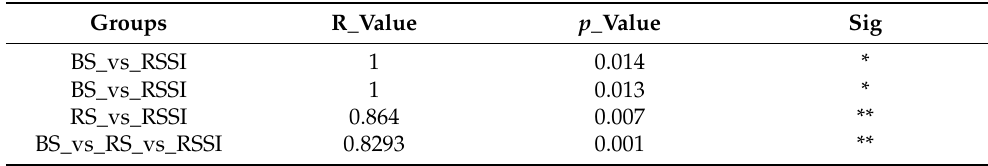
Table 2. Analysis of similarity (ANOSIM) analysis of rhizosphere soil bacterial community structure between treatments. Groups R_Value p _Value Sig BS_vs_RSSI 1 0.014 BS_vs_RSSI 0.013 * RS_vs_RSSI 0.864 0.007 ** BS_vs_RS_vs_RSSI 0.8293 0.001